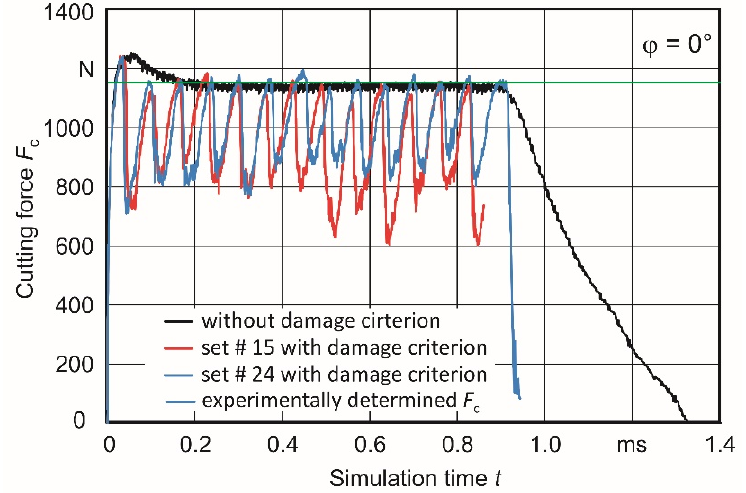
Figure 11. Comparison of simulation-based determined (both with and without damage criterion) and experimentally gained cutting forces F c for φ = 0°. and experimentally gained cutting forces F c for ϕ = 0 ◦ Table 7. Chip Shape Criteria T and D Depending on Model and Experiment-Based Results.